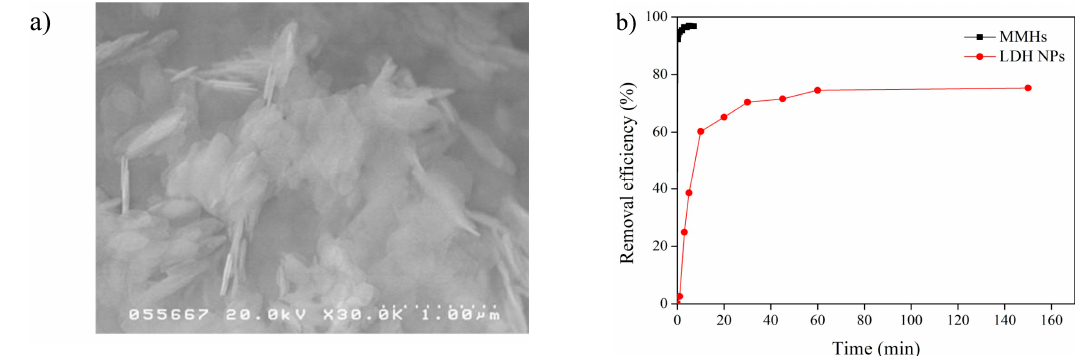
Figure 6. ( a ) SEM image of LDH sorbent and ( b ) its kinetic removal of TC in aqueous solution at an initial concentration of 30 mg L − 1 , compared with MMHs.